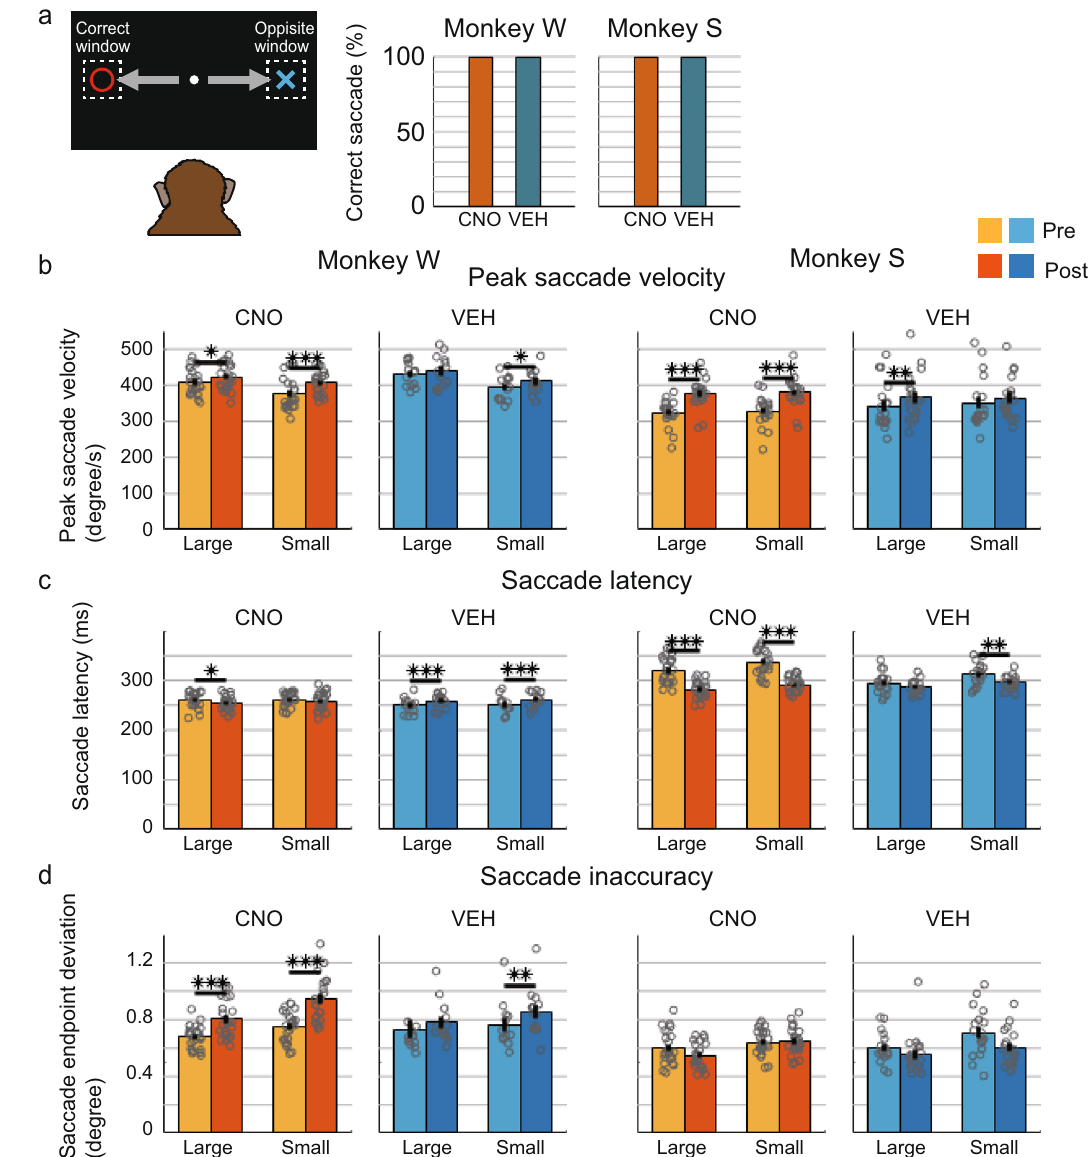
Fig. 3 Change in saccade behavior after the go signal. a Percentage of correct saccade trials among trials in which the monkeys made a saccade either into the correct target window or into the opposite window in the Post period for Monkey W (left) and Monkey S (right). b Peak saccade velocity after the go signal (i.e., after FP offset). Pale colors indicates peak saccade velocity on Pre and deep colors indicates that on Post, separately calculated for large and small reward trials for Monkey W (left) and Monkey S (right). Each dot indicates the mean value per session for each condition. Error bar: standard error of the mean. c Saccade latency (the time from FP offset to the saccade start). d Saccade inaccuracy (the distance between saccade endpoint and the center of the target). FP: fi xation